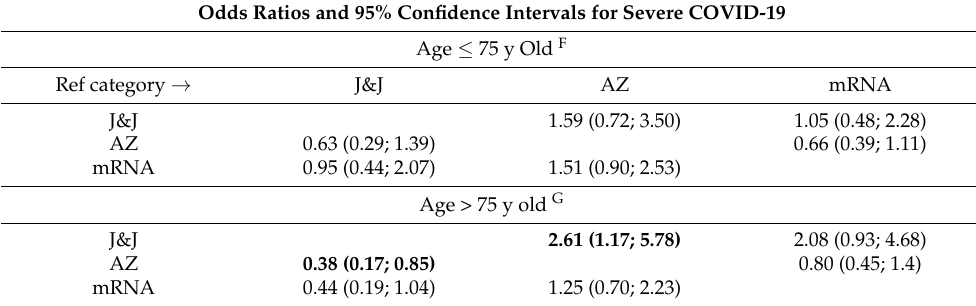
Table 4. Secondary results stratified on age for outcome of severe COVID-19. Odds Ratios and 95% Confidence Intervals for Severe COVID-19